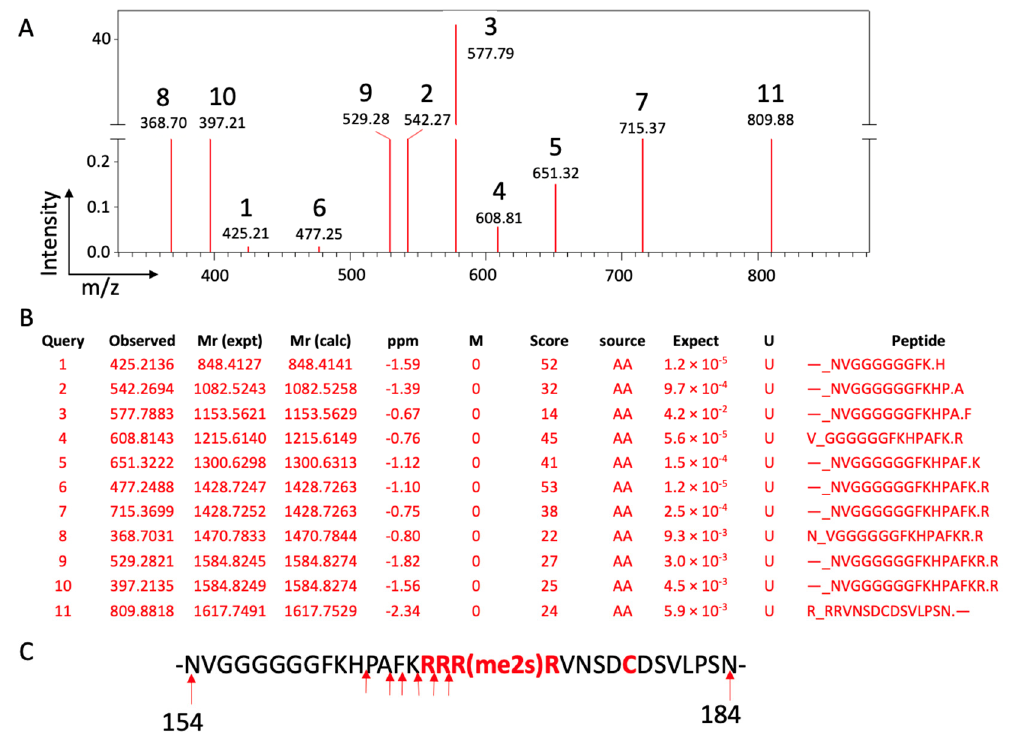
Figure 11. The endopeptidase and amino-exopeptidase activities of JMJD6 on MePCE. ( A ). Mass data from Orbitrap Velos, ( B ). Mass assignments, ( C ). Peptide AA